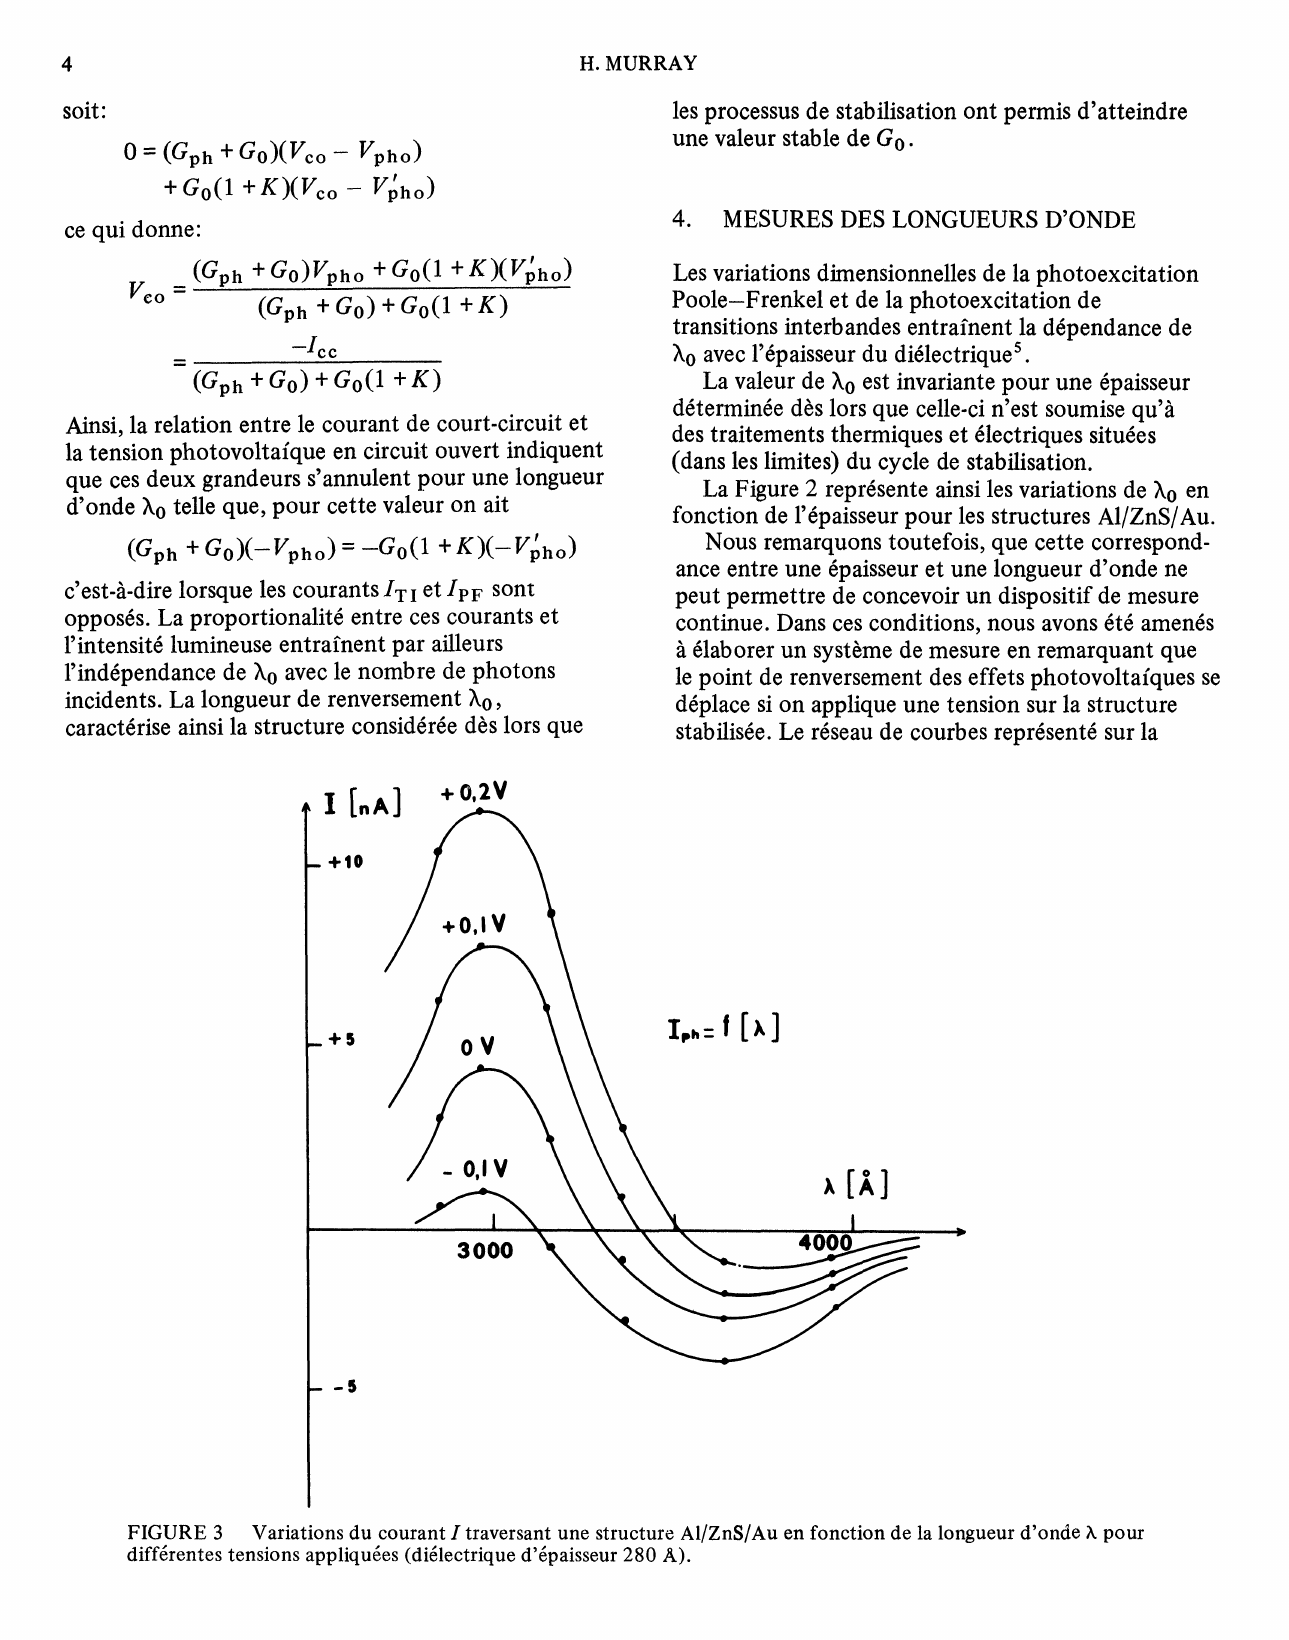
Variations du courant I traversant une structure A1/ZnS/Au en fonction de la longueur d’onde h pour diffgrentes tensions appliques (dilectrique d’paisseur 280